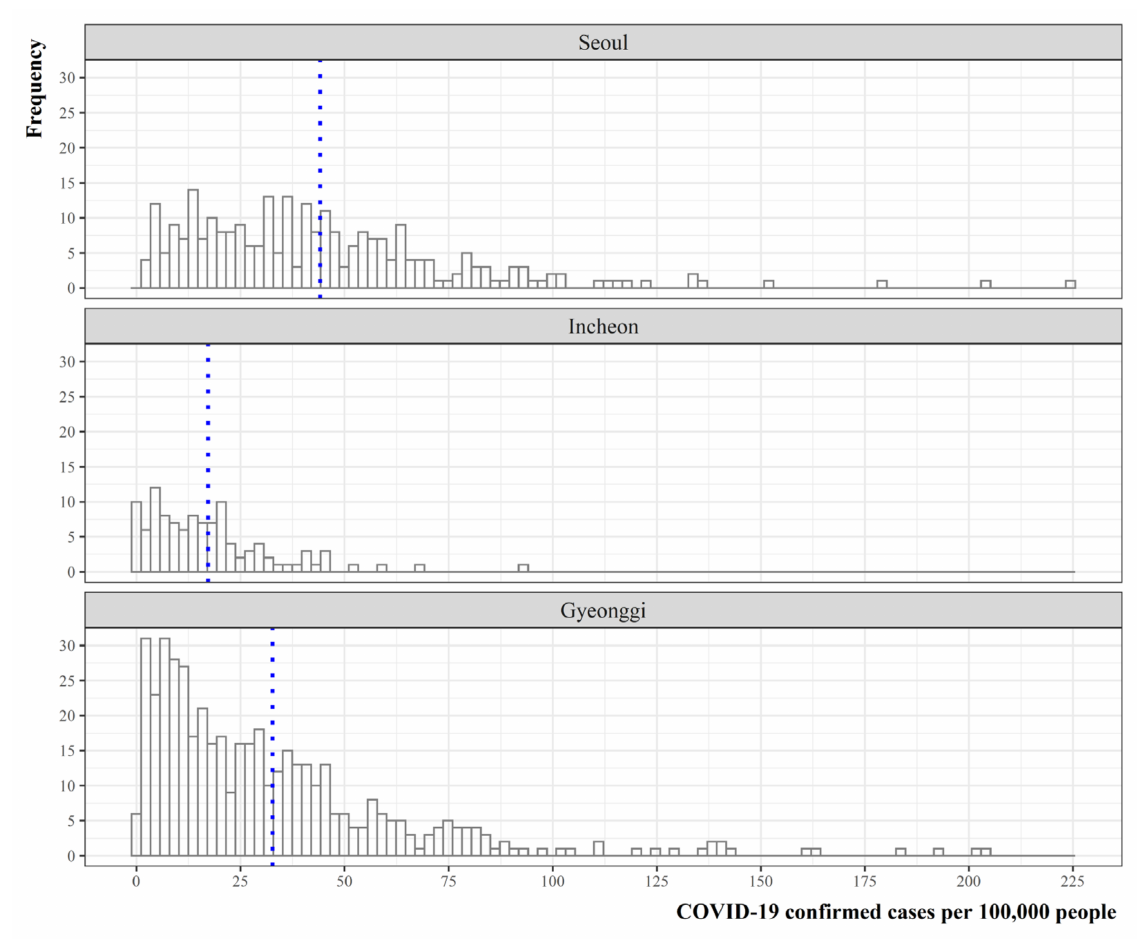
Figure 3. Distribution of COVID-19 confirmed cases (per 100,000 people). Note: the blue dotted vertical lines indicate the average number of confirmed cases for each